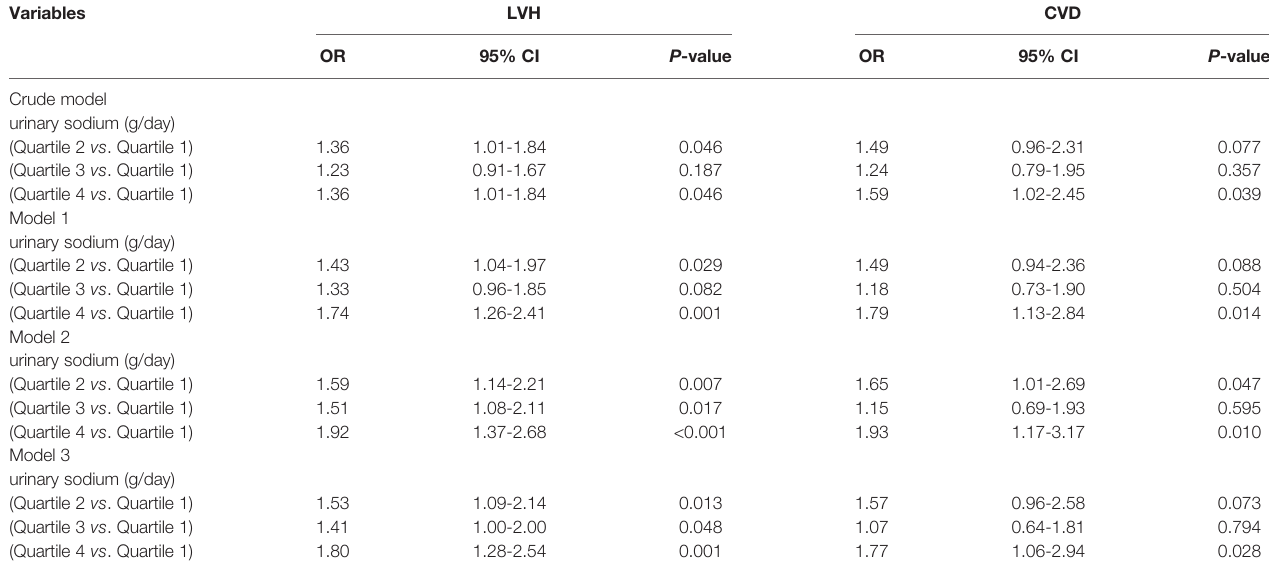
TABLE 4 | Odds ratios (ORs) of LVH and CVD according to urinary sodium excretion levels. Variables